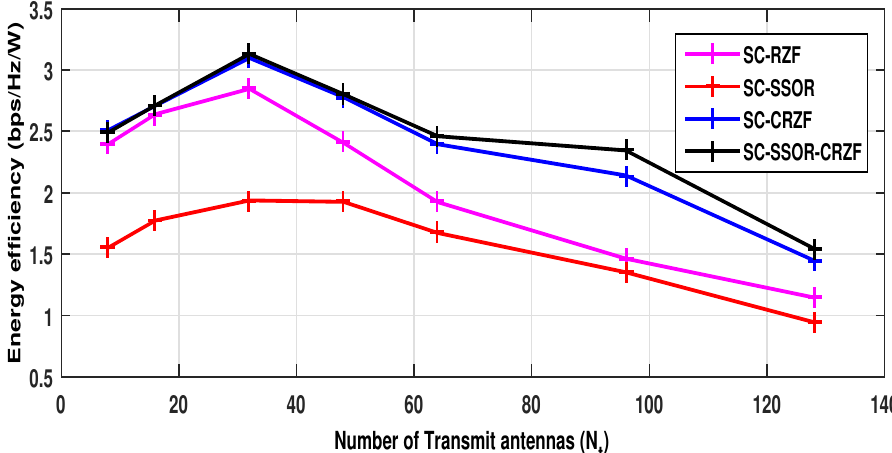
Figure 7. Energy Efficiency Variation with the No of transmitter antennas.